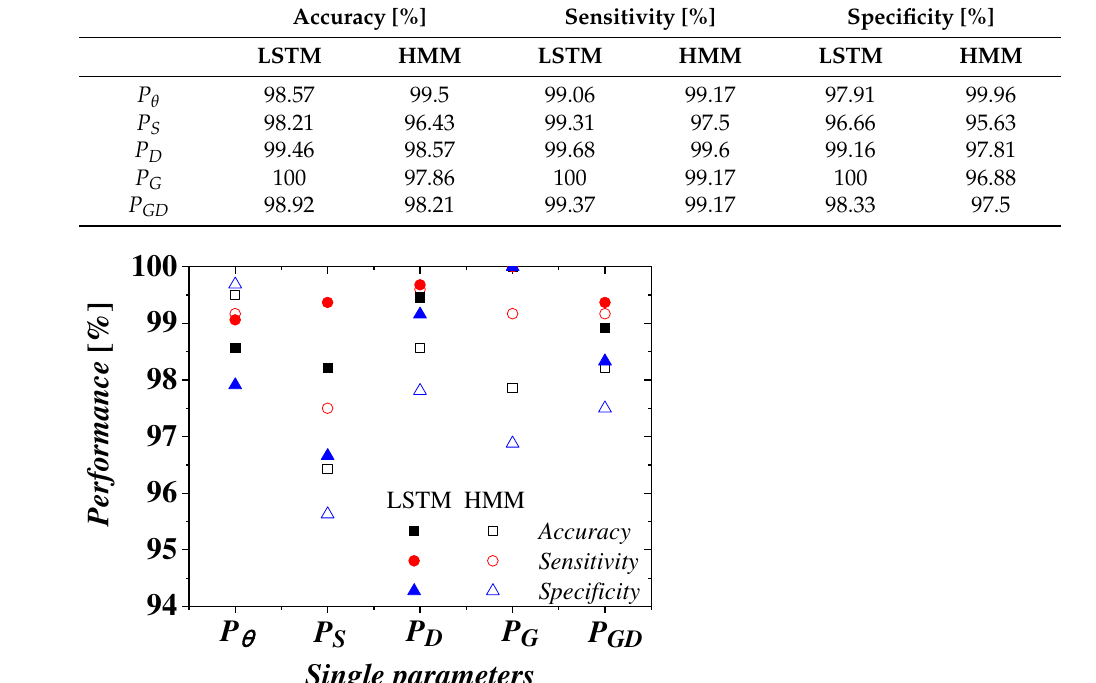
Figure 7. Training data performances of the STM-LSTM and STM-HMM-based fall detection systems, applying the single parameters. Table 4. Fall detection results of the proposed STM-LSTM-based and the previously reported STM- HMM-based fall detection systems, applying the single parameters.